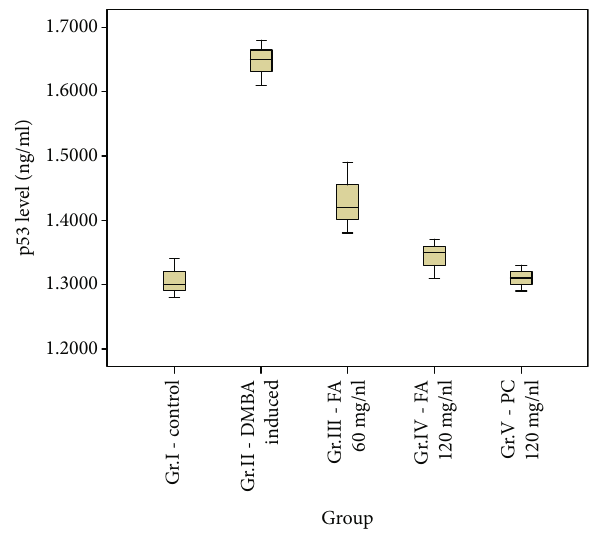
Figure 7: p53 level in skin of experimental mice (DMBA signi fi cantly ( p < 0 : 05 ) increased the p53 level; FA-treated mice signi fi cantly ( p < 0 : 001 ) reduced the p53 level).